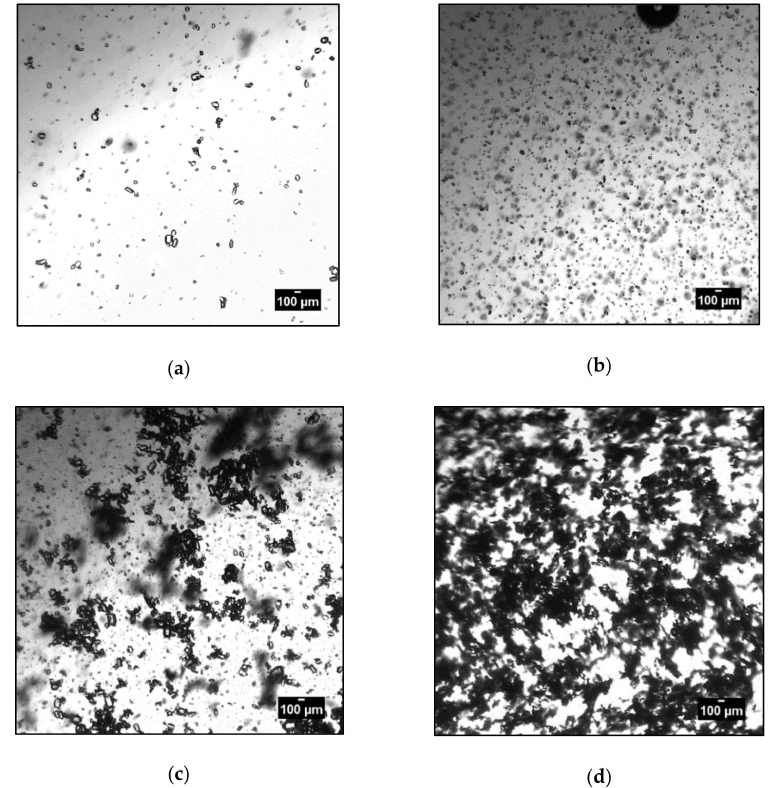
Figure 4. Images taken during the crystallization process in the flow cuvette under a microscope: ( a ) crystals shortly after the first crystals were detected (ultrasound probe; S = 1.39 and P = 4.0 W); ( b ) crystals shortly after the first crystals were detected (rotor–stator mixer; S = 1.39 and P = 2.6 W); ( c ) crystals 80 s after image ( a ) (ultrasound probe; S = 1.39 and P = 4.0 W); ( d ) crystals 20 s after image ( b ) (rotor–stator mixer, S = 1.39 and P = 2.6